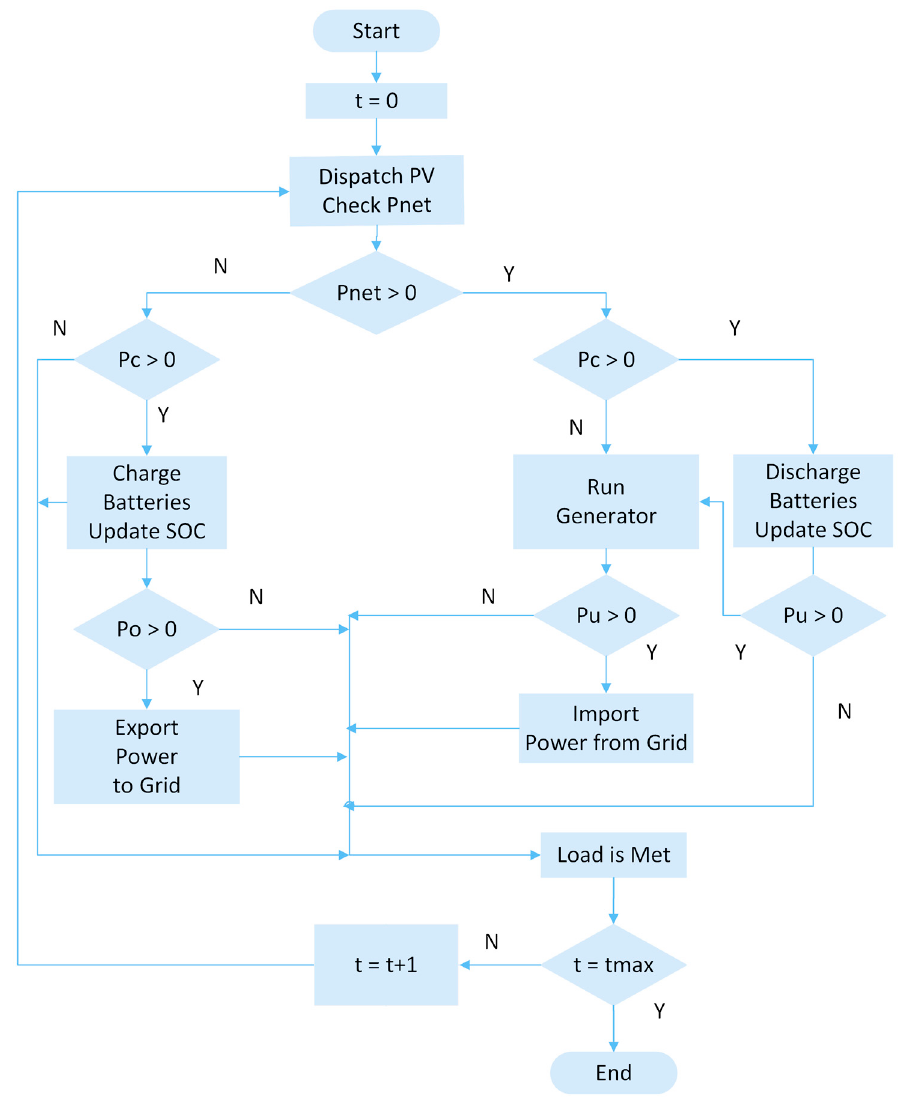
Figure 2. The dispatch logic of the di ff erent power sources.